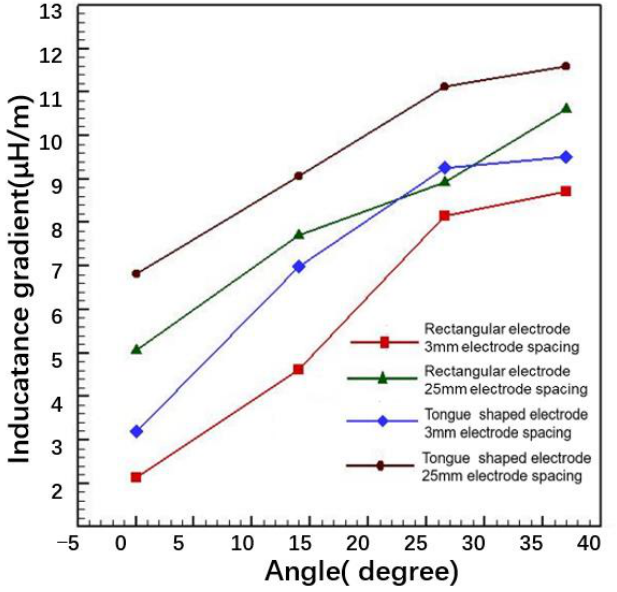
Figure 7. The variation of the inductance gradient with the flare angle of different electrode configurations.